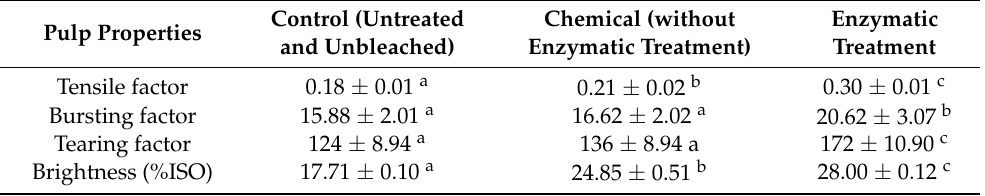
Table 6. Various physical attributes of biobleaching OPEFB